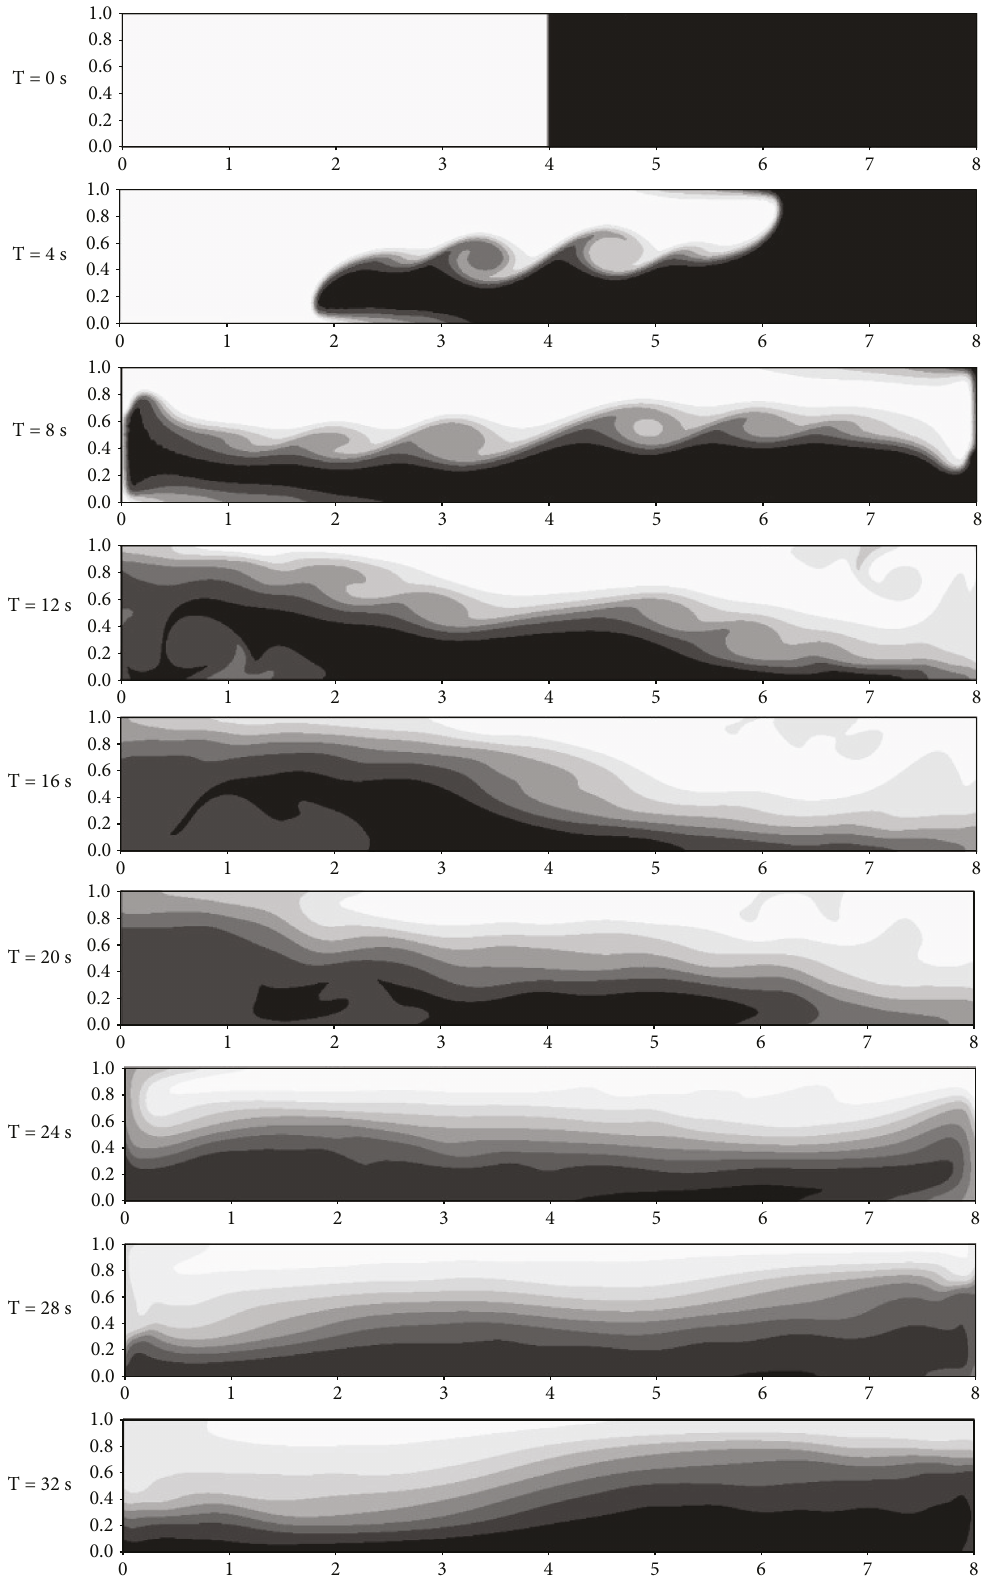
Figure 19: Time evolution of the temperature fi eld for a two-dimensional Buoyant mixing fl